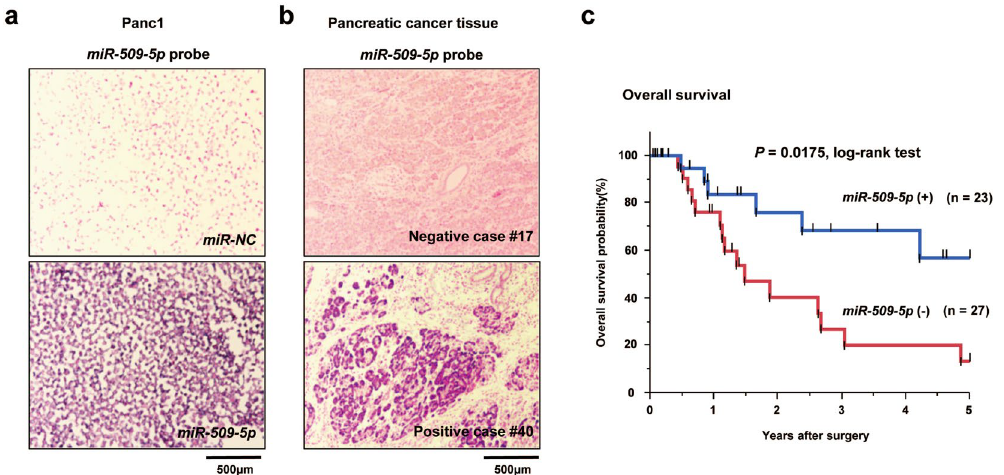
Figure 6. The expression of miR-509-5p is associated with overall survival in human PDAC. ( a , b ) Representative results of the in situ hybridization for miR-509-5p . ( a ) FFPE of Panc1 cells 24 hours after transfection with miR-NC (upper) and miR-509-5p (bottom). ( b ) Primary PDAC with negative staining (upper) and positive staining (bottom). ( c ) Kaplan-Meier curves for the overall survival rates of patients with primary PDAC. A lack of miR-509-5p expression in tumor cells was significantly associated with a worse overall survival ( P = 0.0175, log-rank